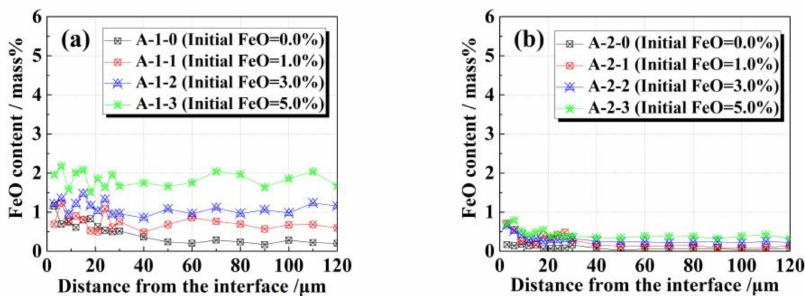
Figure 10. Change in the FeO content of the oxide near the interface in diffusion couples after isothermal heating at 1273 and 1473 K for 10 h: ( a ) A-1- x ; ( b ) A-2- x